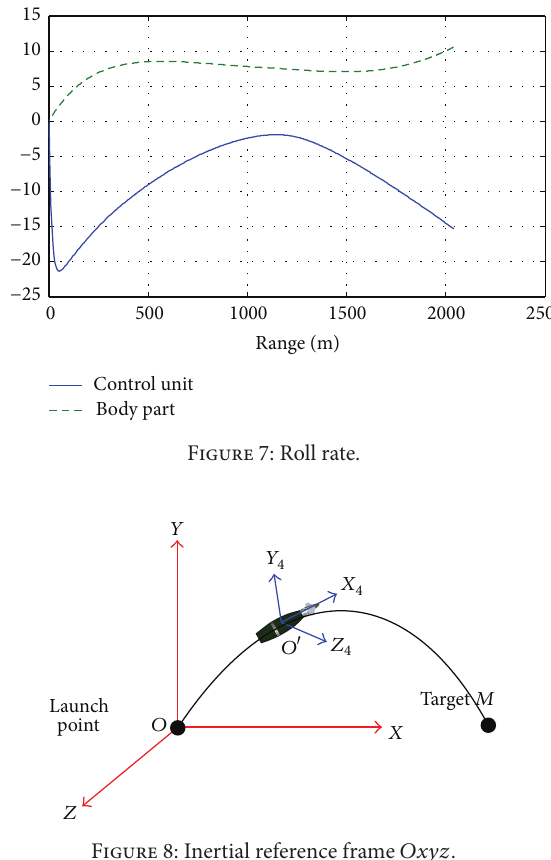
Figure 8: Inertial reference frame 𝑂𝑥𝑦𝑧